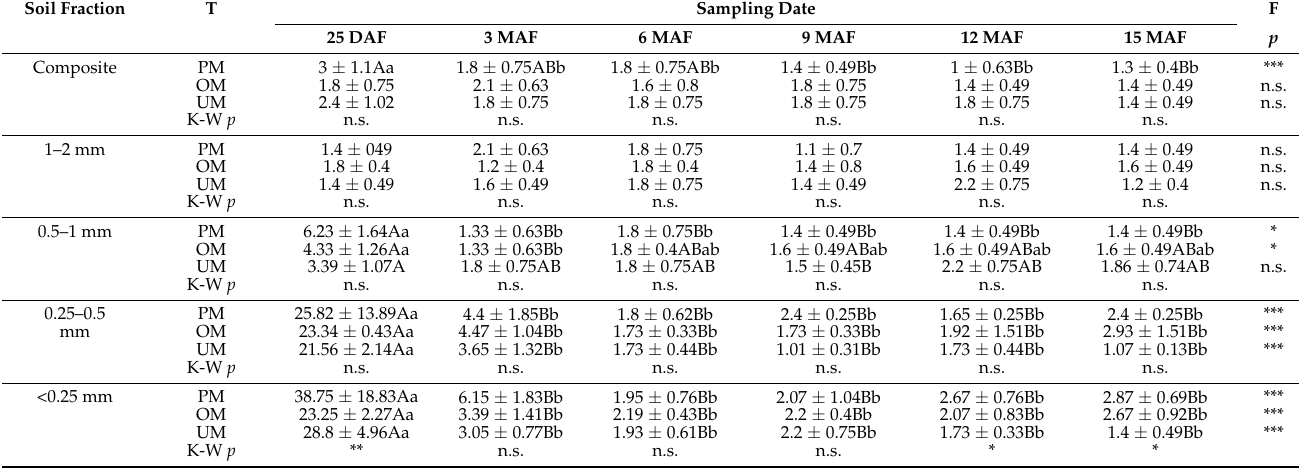
Table 1. Soil water repellence (SWR) was measured with water drop penetration time (s) on different soil fractions in the pine mulch (PM), olive mulch (OM), and unmulched (UM) treatments during the studied period (T, treatments; DAF, days after fire; MAF, months after fire) (mean ± standard deviation). Different letters indicate significant differences between sampling dates (capital letters), and treatment (lowercase letters). Kruskal–Wallis (K-W) (* p < 0.05, ** p < 0.01, *** p < 0.001, and n.s. non-significant at p < 0.05) are shown for each comparison between treatments, and Friedman ANOVA (F) between sampling